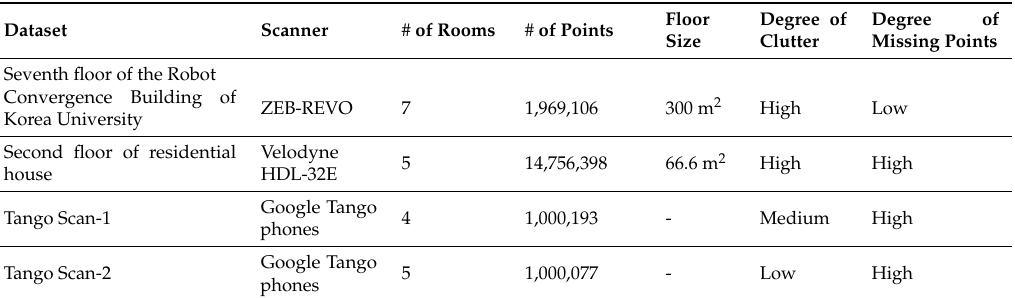
Table 1. Details of datasets.